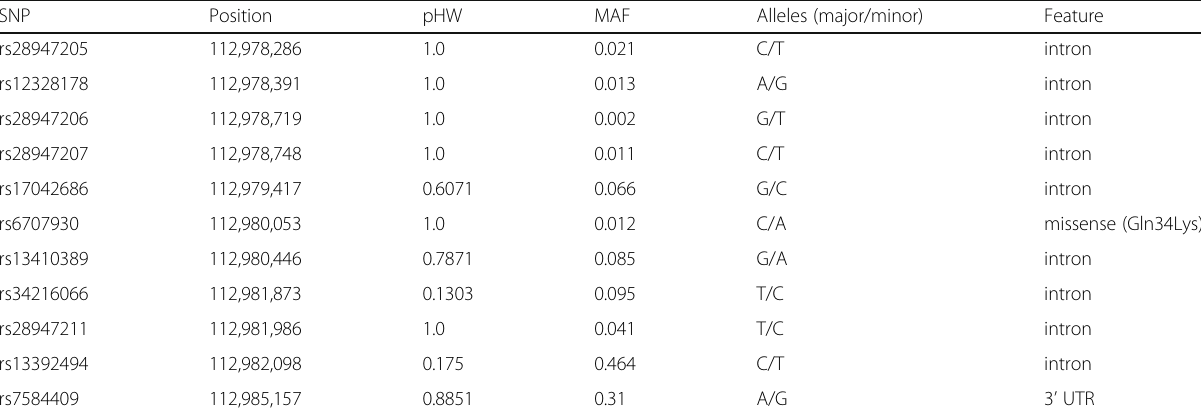
Table 1 Characteristics of studied